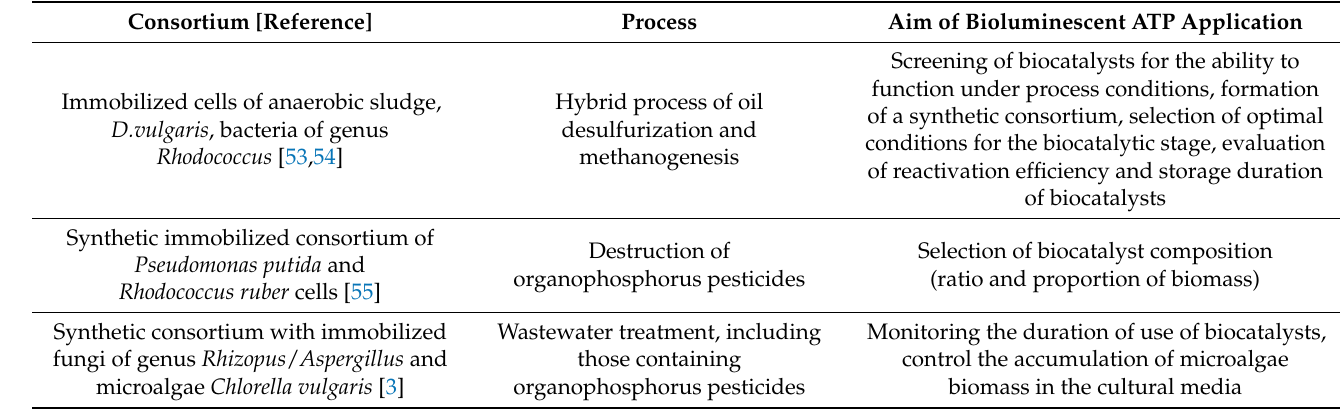
Table 3. Application of bioluminescent ATP-assay for the study and directed regulation of biocatalytic processes using artificial consortia of